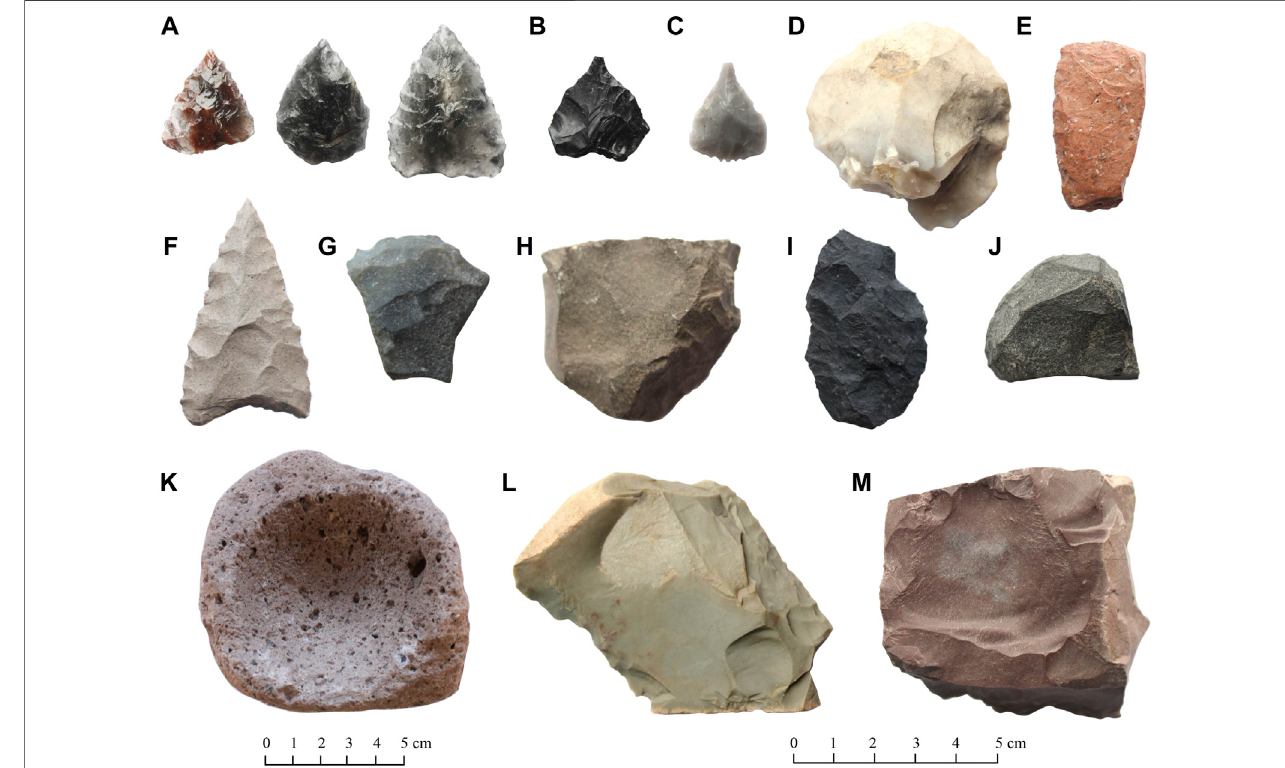
FIGURE 2 | Lithic assemblages and raw materials: (A) bifacial projectile points in gray translucent obsidian (Tuina-5 and Tambillo-1); (B) micro-perforator in shiny black obsidian (Tambillo-1); (C) bifacial perforator in opaque gray obsidian (Tulán-67); (D) end-scraper on white chert (Tuina-5); (E) side-scraper on red dacitic tuff (Tambillo-1); (F) bifacial projectile point on gray silici fi ed tuff; (G) retouched fl ake on greenish ash dacitic tuff (Tambillo-1); (H) core on devitri fi ed brown tuff (Tulán-67); (I) retouched piece on black andesite with crystals (Tambillo-1); (J) end-scraper on black aphiric andesite (Tulán-67); (K) container-mortar on gray-pink pumice (Tambillo-1); (L) retouched fl ake on epidotized siliceous rock (Tuina-5); (M) core on brown andesitic tuff (Tuina-5).